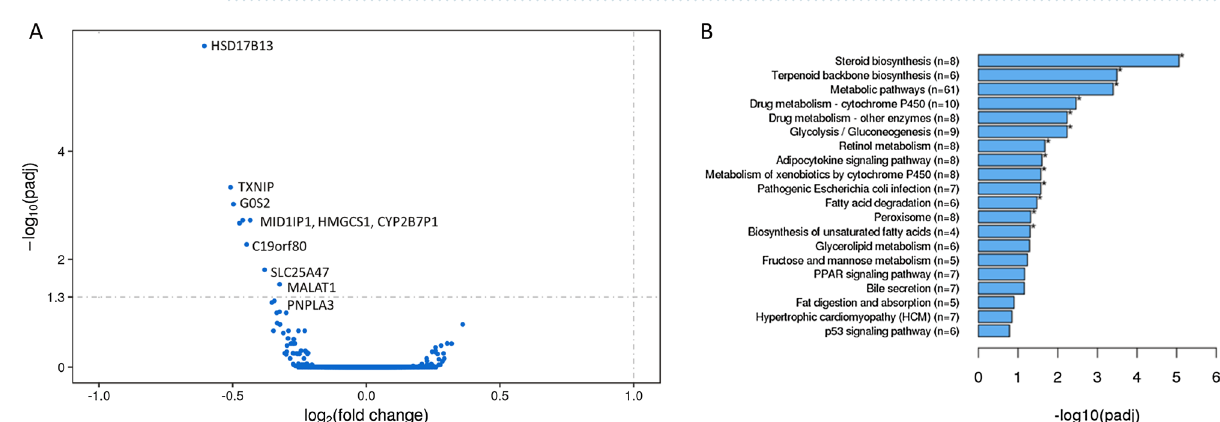
Figure 4. Gimeracil inhibition of DPYD perturbs metabolic processes related to cholesterol and lipid biosynthesis. ( A ) A volcano plot describing the key genes with differential expression levels in the presence of 400 nM Gimeracil and 200 µM free fatty acids relative to Vehicle control with 200 µM free fatty acids. Log2 fold change and − log10 adjusted p values were plotted for the detected genes. HSD17B13 is the most differentially regulated gene, followed by TXNIP, G0S2, and MID1IP1. ( B ) Pathway analysis reveals significant disruption in pathways associated with lipid, cholesterol and coenzyme metabolic processes in cells treated with 400 nM Gimeracil and 200 µM FFAs relative to vehicle control and 200 µM FFAs. N = 3 samples per